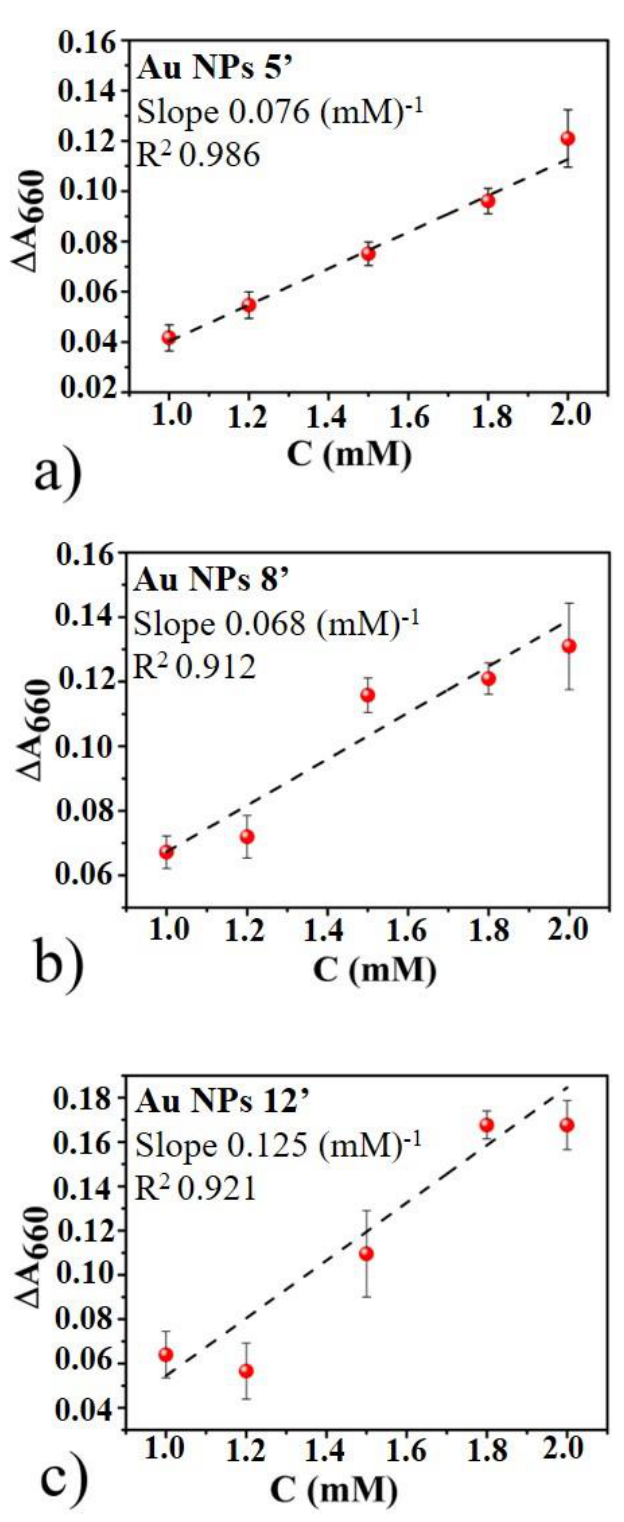
Figure 7. The plots of ∆ A 660 ( A with glyphosate − A without glyphosate ) at 660 nm at di ff erent glyphosate concentrations for 5′ AuNPs ( a ), 8′ Au NPs ( b ) and 12′ AuNPs ( c ).